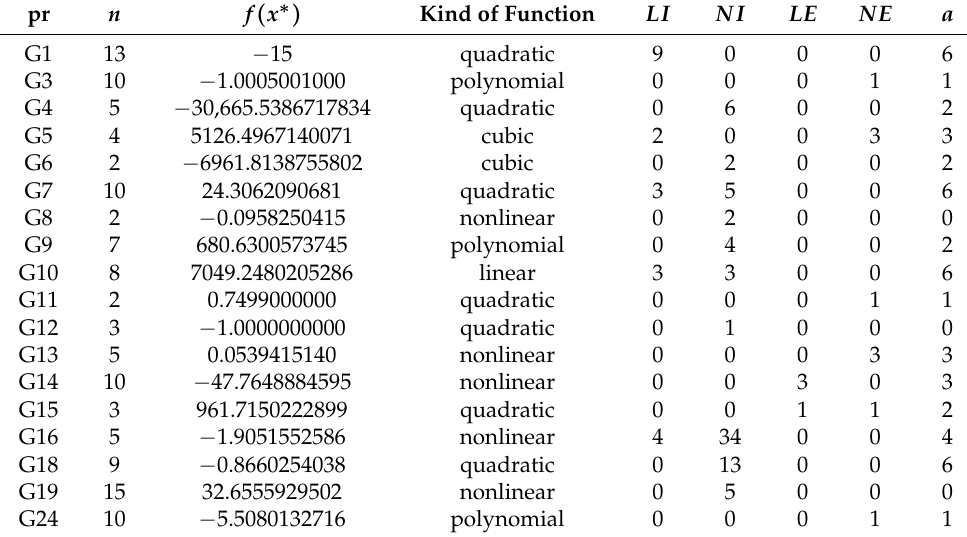
Table 1. List of first and second types of test problems and their exact